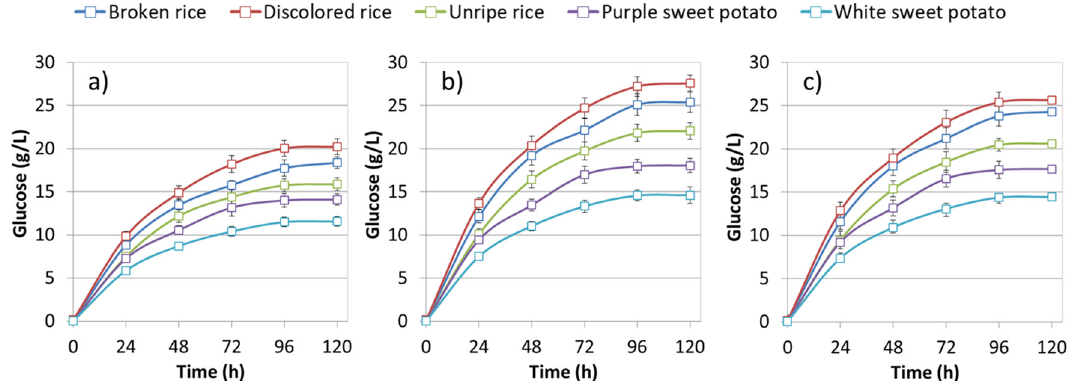
Figure 2. Glucose release (g/L) under saccharification of different starchy substrates (3% w / v ) with increasing loadings of STARGEN ™ 002: ( a ) 1.06 (low), ( b ) 1.42 (medium) and ( c ) 1.77 (high) µ L per g of starch.